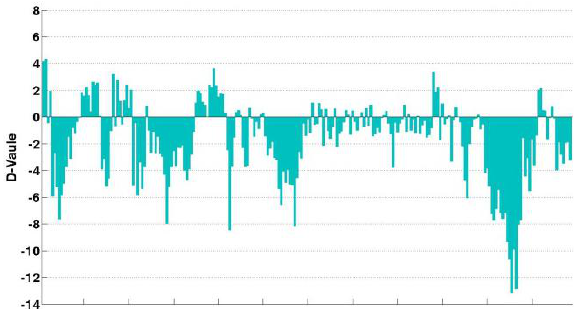
Figure 2. Bevis empirical formula model residual errors